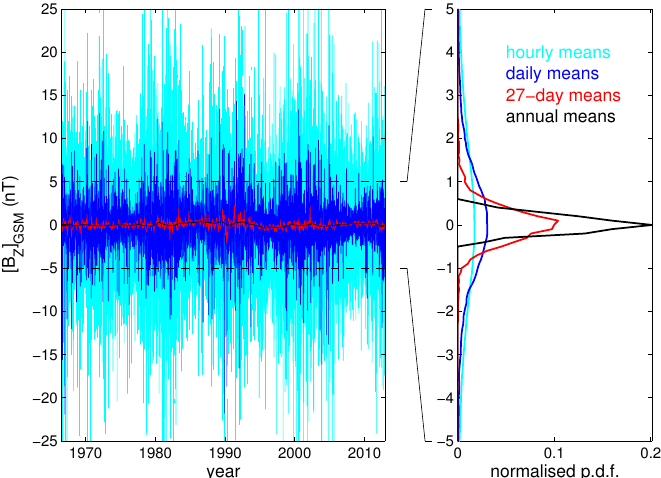
Figure 9: The northward component of the near-Earth interplanetary magnetic field (IMF) in the GSM frame, 𝐵 𝑍 , from the OMNI2 composite dataset. The left-hand plot shows the temporal variations of ⟨ 𝐵 𝑍 ⟩ 𝑇 for 1966 – 2013 at different averaging timescales, T . The right-hand plot shows the corresponding probability density functions over the same interval. Note the difference in the vertical scales. In both panels light blue is for T = 1 h, dark blue for T = 1 day, red for T = 27 days and black for T = 1